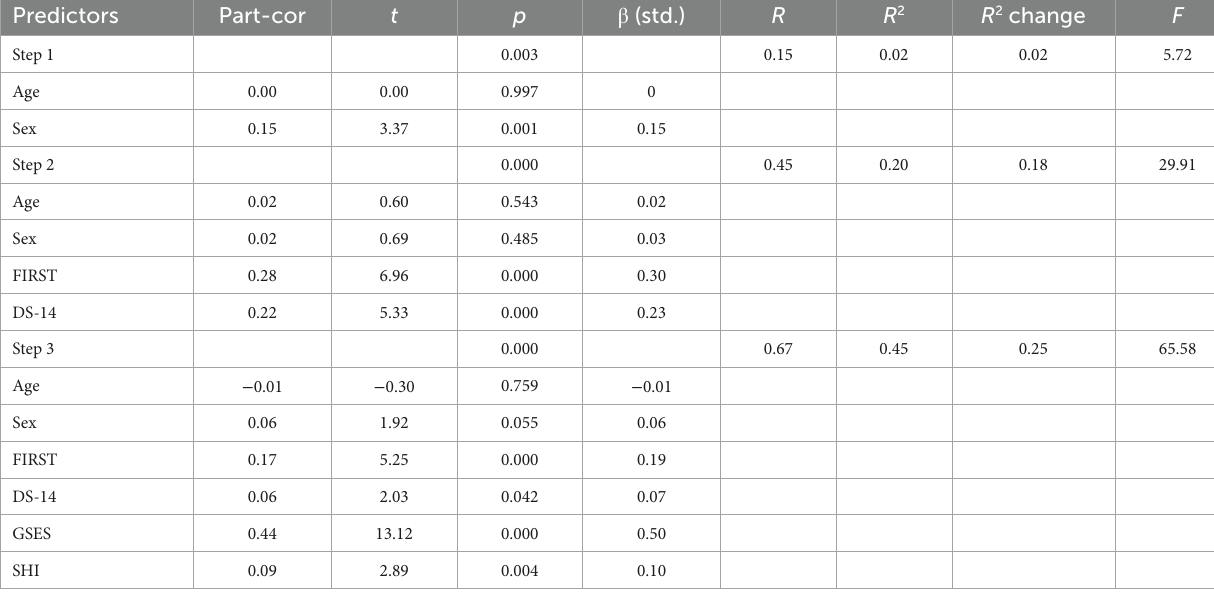
TABLE 4 Hierarchical regression analysis of insomnia severity ( N = 474).